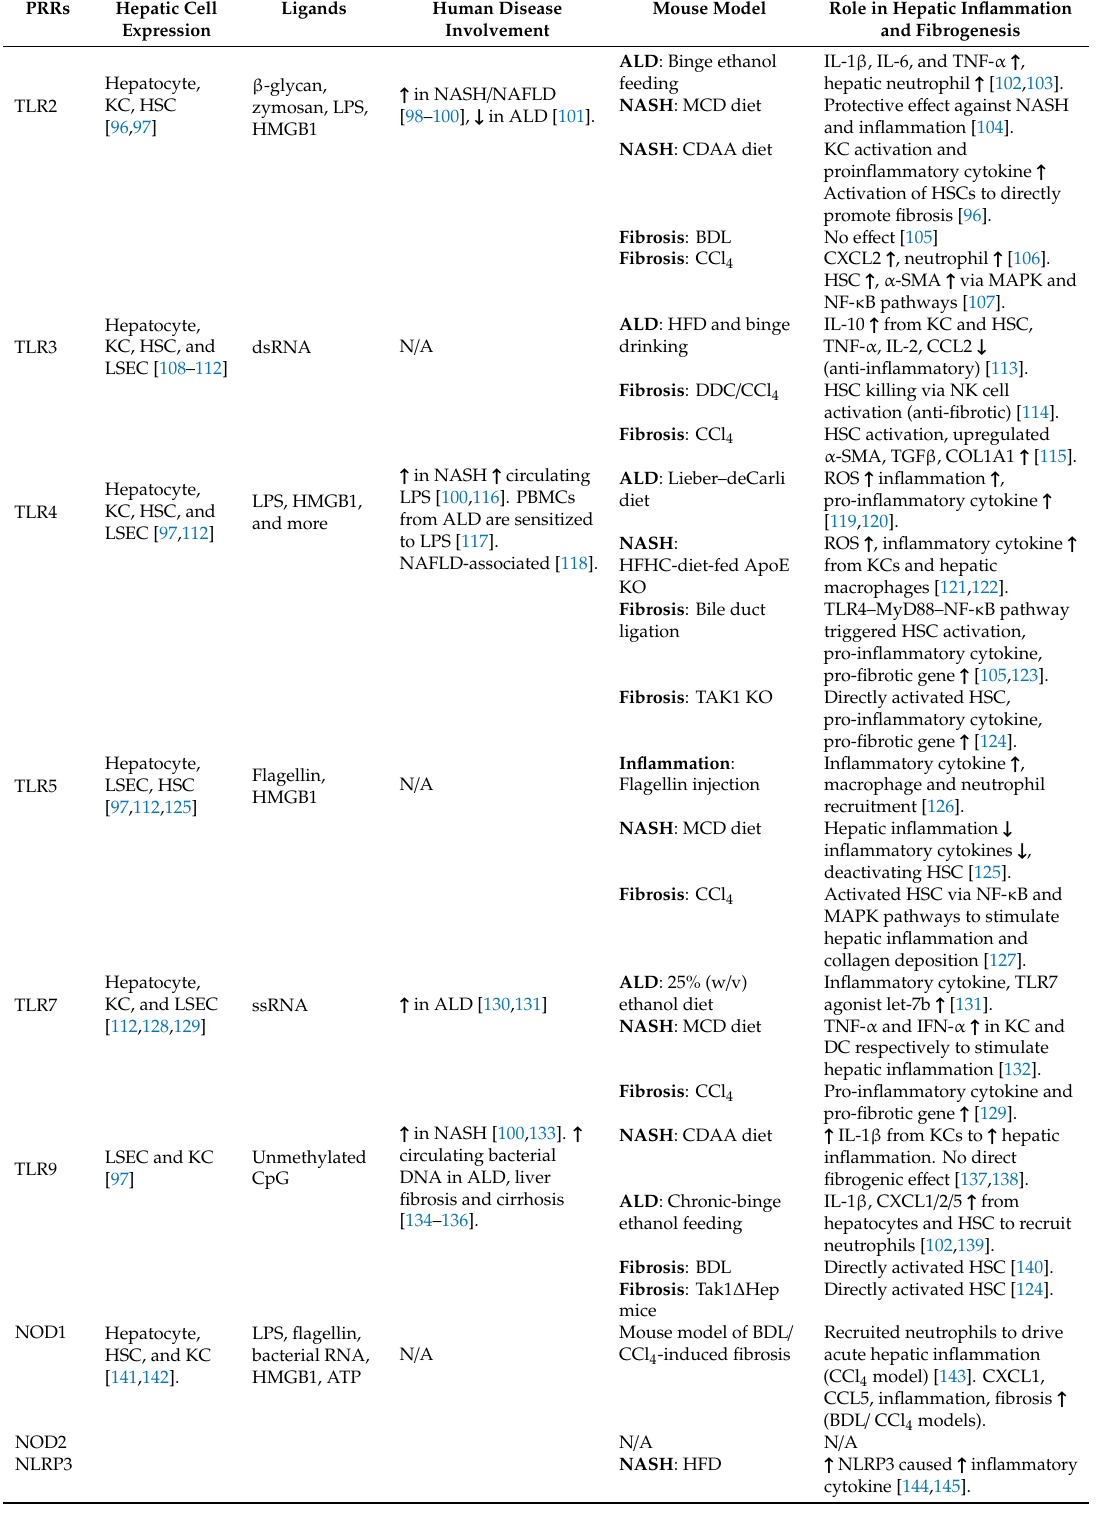
Table 2. Pattern recognition receptors (PRRs) that contribute to hepatic inflammation and fibrogenesis.